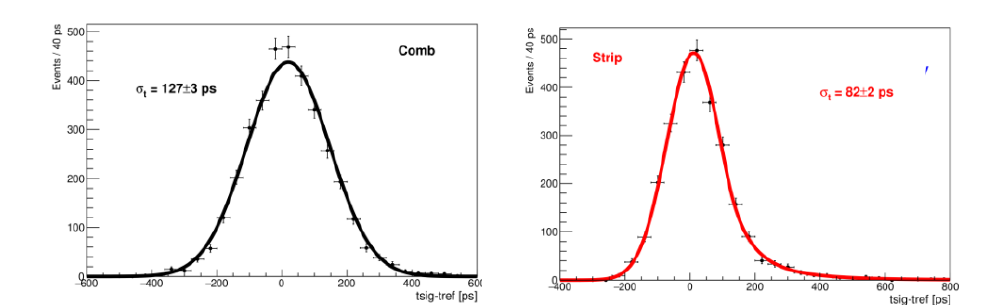
Figure 11. ( Left ): delay distribution of the comb test structure. ( Right ): delay distribution of the strip test structure.